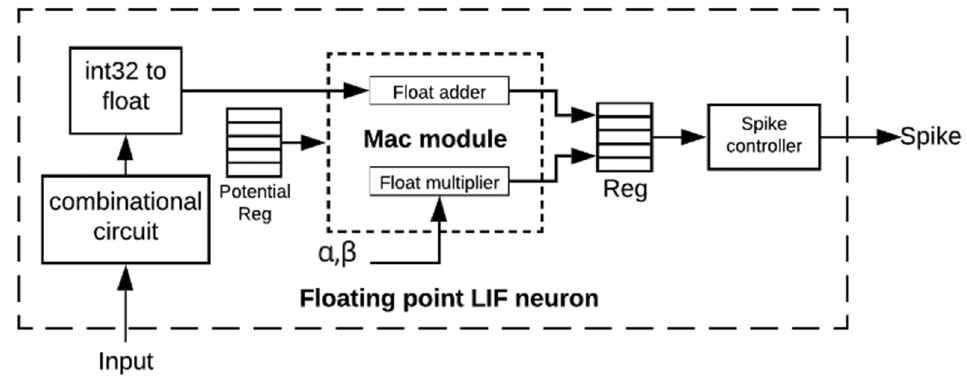
Figure 6. The architecture of the fl oating-point LIF neuron.